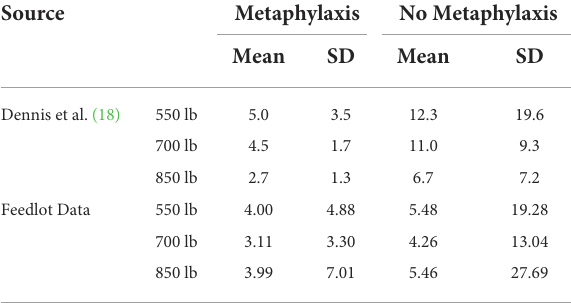
TABLE 6 Feedlot death loss for cattle given metaphylaxis and not given metaphylaxis.